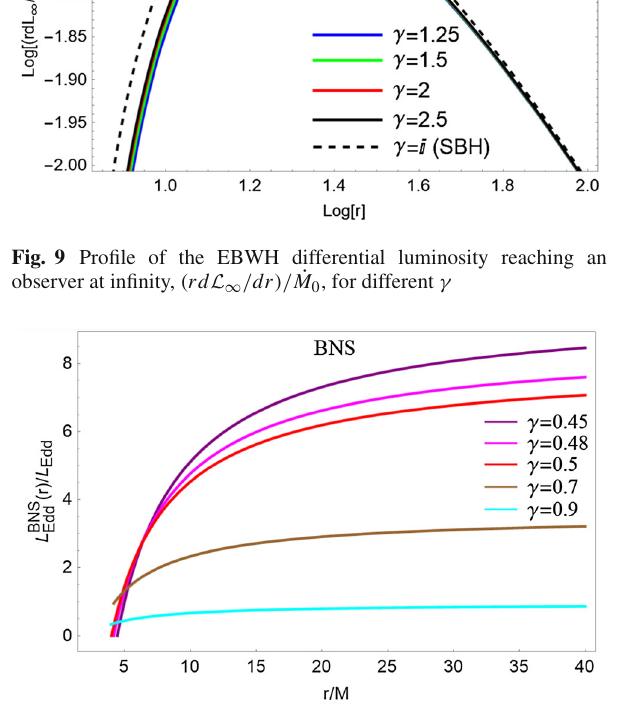
Fig. 10 The Eddington luminosity of BNS for different values of γ